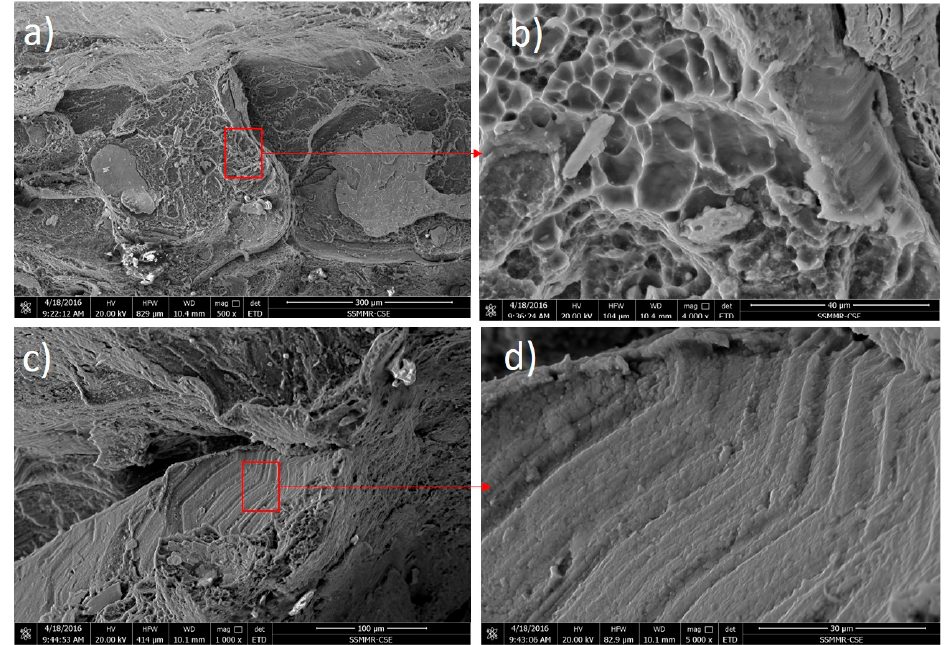
Figure 11. SEM micrographs of the fracture surfaces of FSWed joints welded at 200 rpm and 50 mm/min at different positions: ( a , b ) low and high magnification for a dimple feature position and ( c , d ) low and high magnification in the cleavage fracture position.